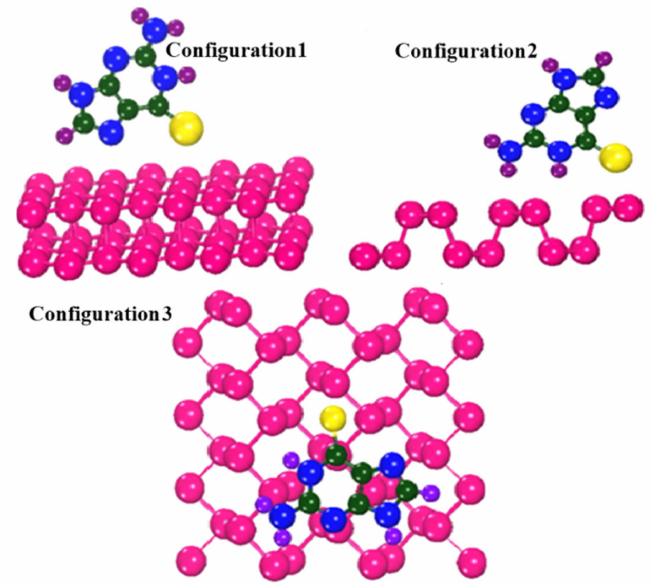
Figure 4. Different configurations of phosphorene–thioguanine complex.